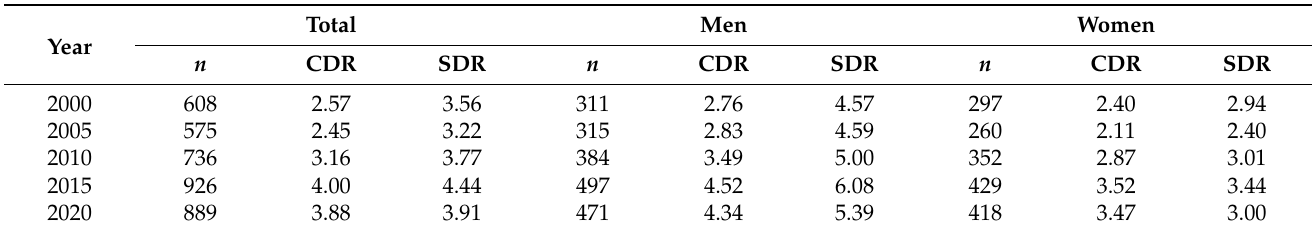
Table 3. Number of deaths, CDR per 100,000 and SDR per 100,000 due to skin melanoma of urban residents in Poland by gender in 2000, 2005, 2010, 2015 and 2020. Total Men